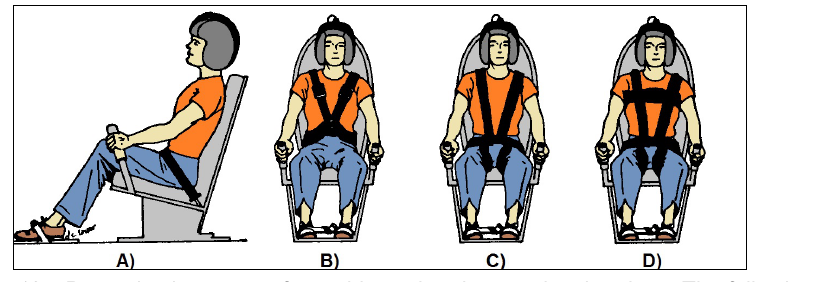
Figure 12 – Protective harnesses for rapid accelerations or decelerations. The following devices were evaluated in sled deceleration tests: (A) Seat belt for automobiles and commercial aviation (B) Standard military lap and shoulder strap (C) Like (B) but with thigh straps added to prevent head- ward rotation of the lap strap (D) Like (C) but with chest strap